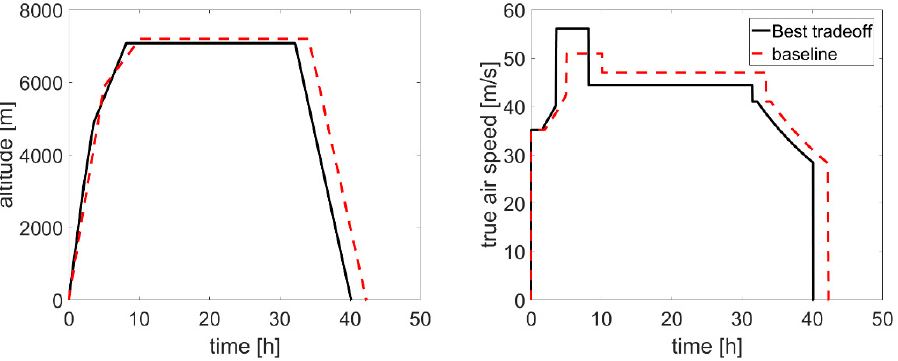
Figure 13. Profile mission of the “Best_tradeoff” solution of Test Case 2.